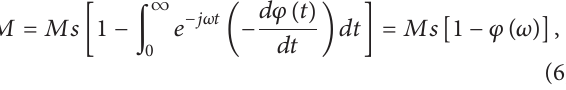
F 11: Variation of imaginary part of modulus frequency for [(C at different